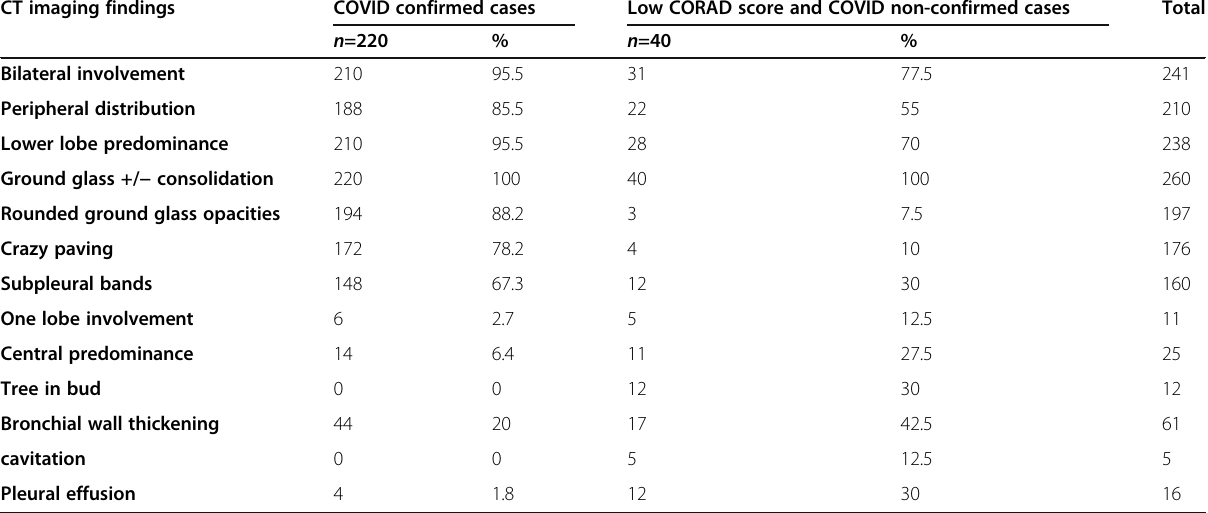
Table 4 CT findings in all cases CT imaging